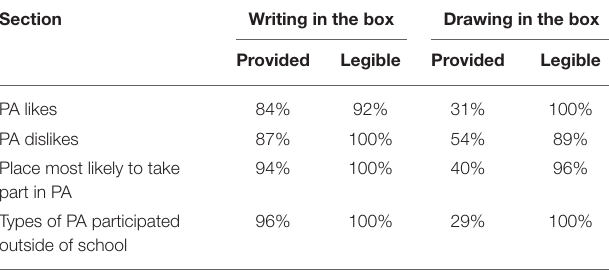
TABLE 1 | Write and draw task completion by